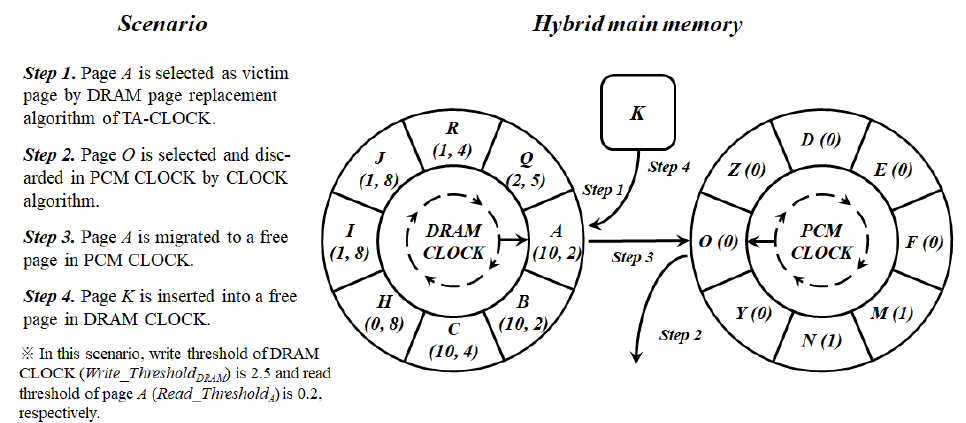
Figure 3. Example of page allocation in the DRAM CLOCK and page migration from the DRAM CLOCK to the PCM